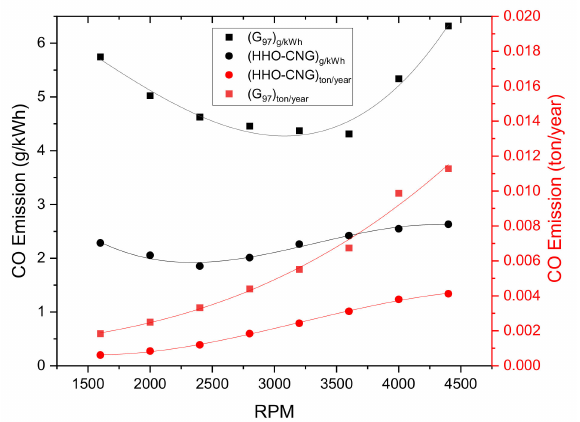
Figure 8. CO emission variation with respect to engine speed in terms of parts per million and